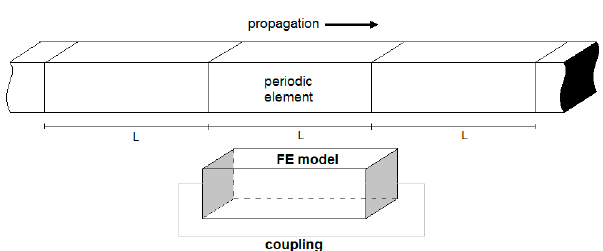
Figure 6. Scheme showing the portion of the waveguide modeled using 3D finite element analysis (FEM) for the Sorohan et al. [25] in the semi-analytical finite element method (SAFE) implementation. The pair of frequencies and wave number ( f , k ) associated with each wave mode were identified manually scanning the frequency range of interest, FEM models with L of 0.5, 0.25, 0.1 and 0.005 [m] were